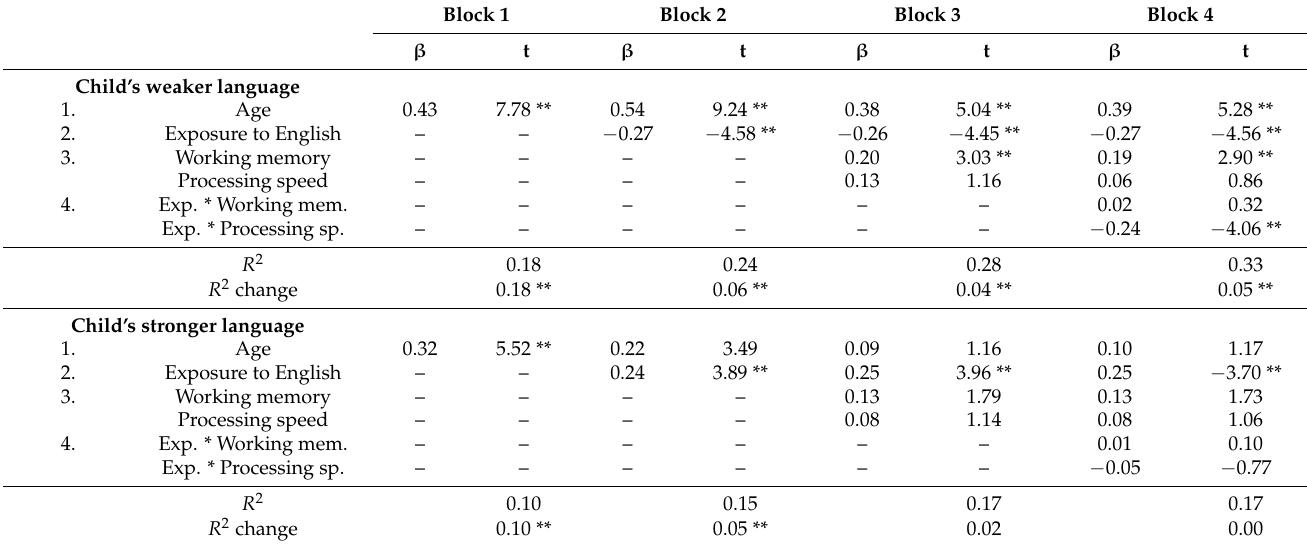
Table 7. Model summaries of regressions predicting morphosyntax using cloze tasks in children’s weaker and stronger languages.